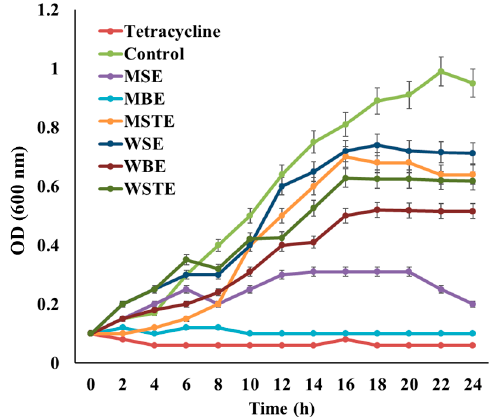
Figure 7. Analysis of the growth curve for antimicrobial activity of MIC concentration of different plant extracts against MRSA. methanolic seed extract (MSE-MIC:10.24 μ g·mL -1 ), methanolic bark